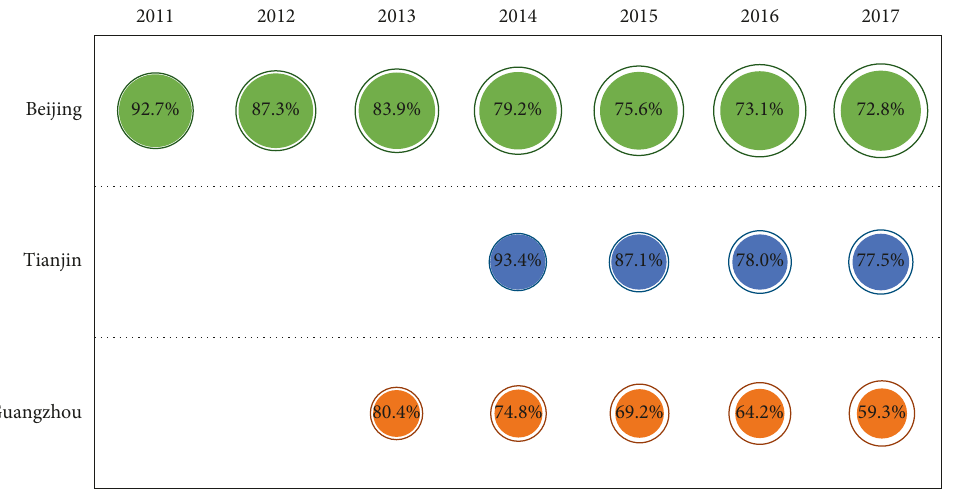
Figure 12: Actual and fitted values of vehicle stock in Beijing, Tianjin, and